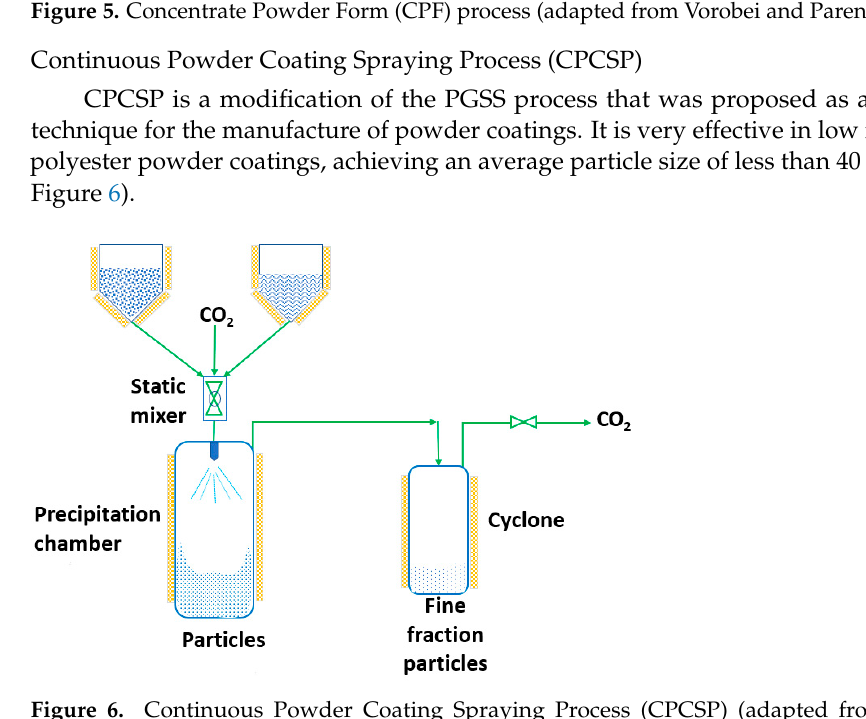
Figure 6. Continuous Powder Coating Spraying Process (CPCSP) (adapted from Nunes and Duarte [139]).